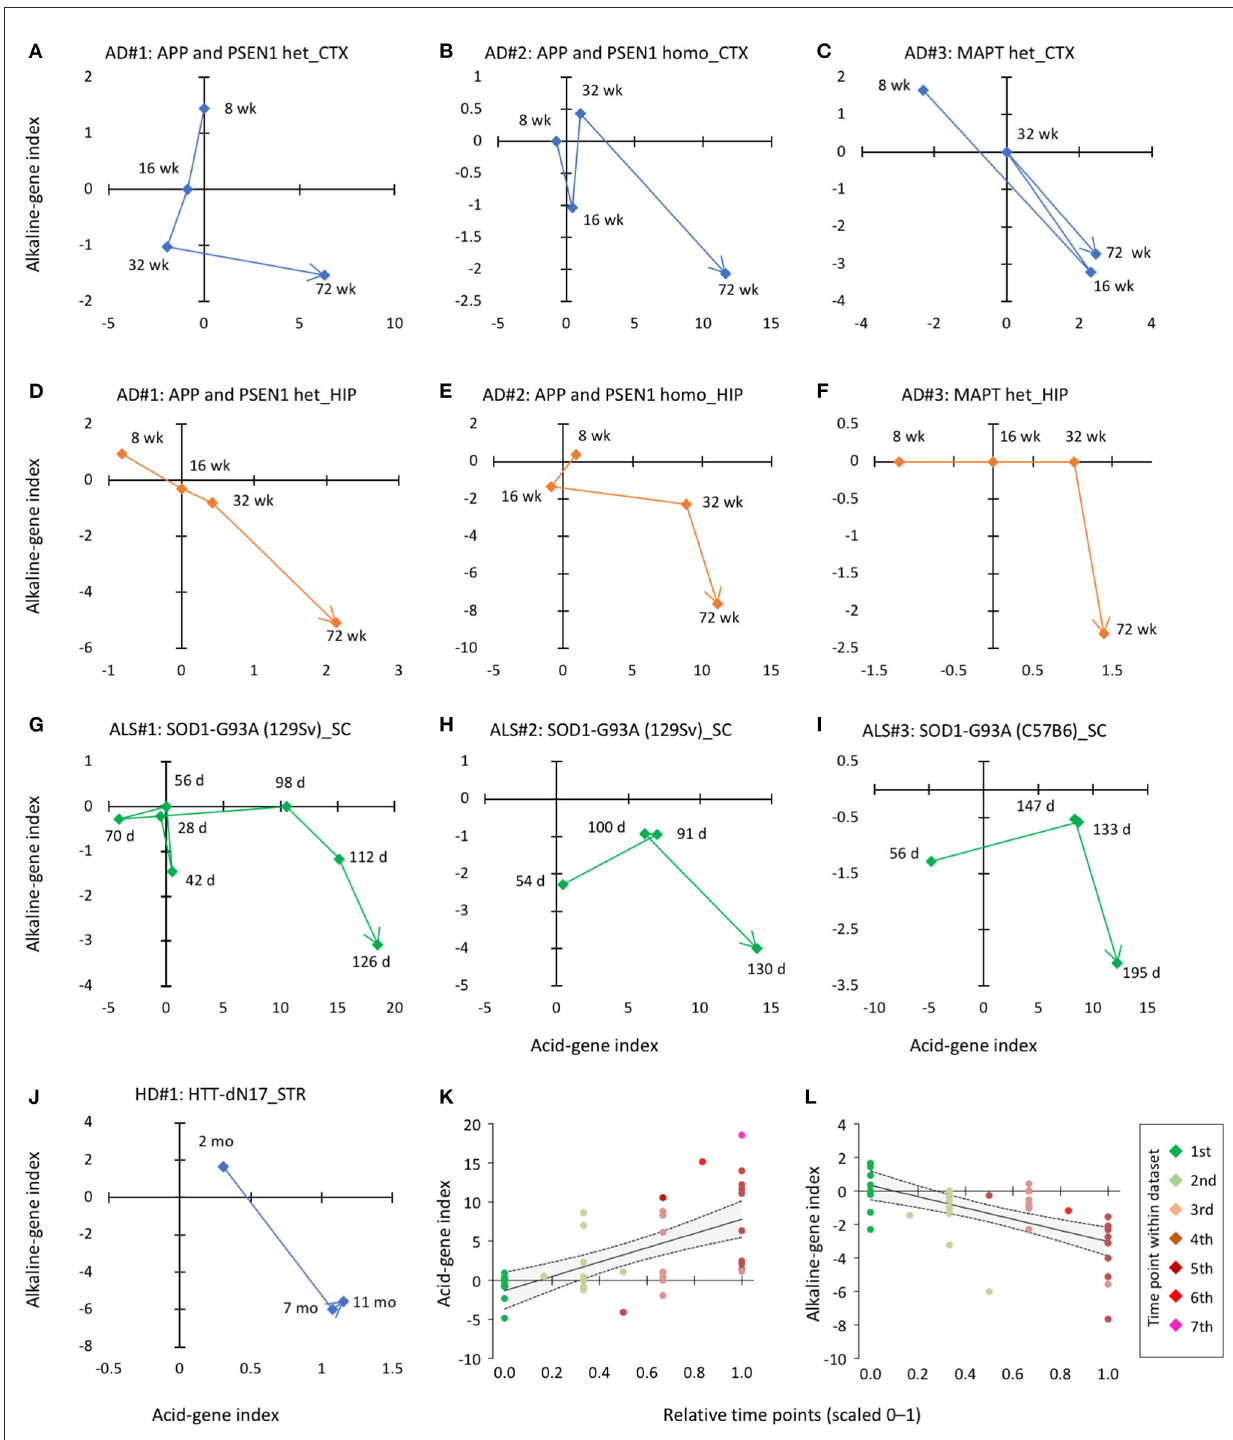
FIGURE4 Time-dependent changes in acid-gene and alkaline-gene indices in mouse models of neurodegenerative disorders. (A–F) Pattern of changes in acid-gene and alkaline-gene indices in the cortex [CTX; (A–C) ] and hippocampus [HIP; (D–F) ] of AD mouse models with heterozygous mutation in APP and PSEN1 (A, D) , homozygous mutation in APP and PSEN1 (B, E) , and heterozygous mutation in MAPT (C, F) (GSE64389). (G–I) Patterns of changes in acid-gene and alkaline-gene indices in the spinal cord (SC) of an ALS mouse model with the SOD1 (G93A) mutation (GSE18597, GSE46298). (J) Patterns of changes in acid-gene and alkaline-gene indices in the striatum (STR) of an HD mouse model with the huntingtin (HTT) mutation (GSE64386). d, days old; wk, weeks old. (K, L) Scatter plots showing the correlation between time point and acid-gene index and alkaline-gene index of ten datasets. Time points were normalized within each dataset and expressed on a scale of 0–1. Regression line (solid line) and 95% confidence intervals (dashed line) are